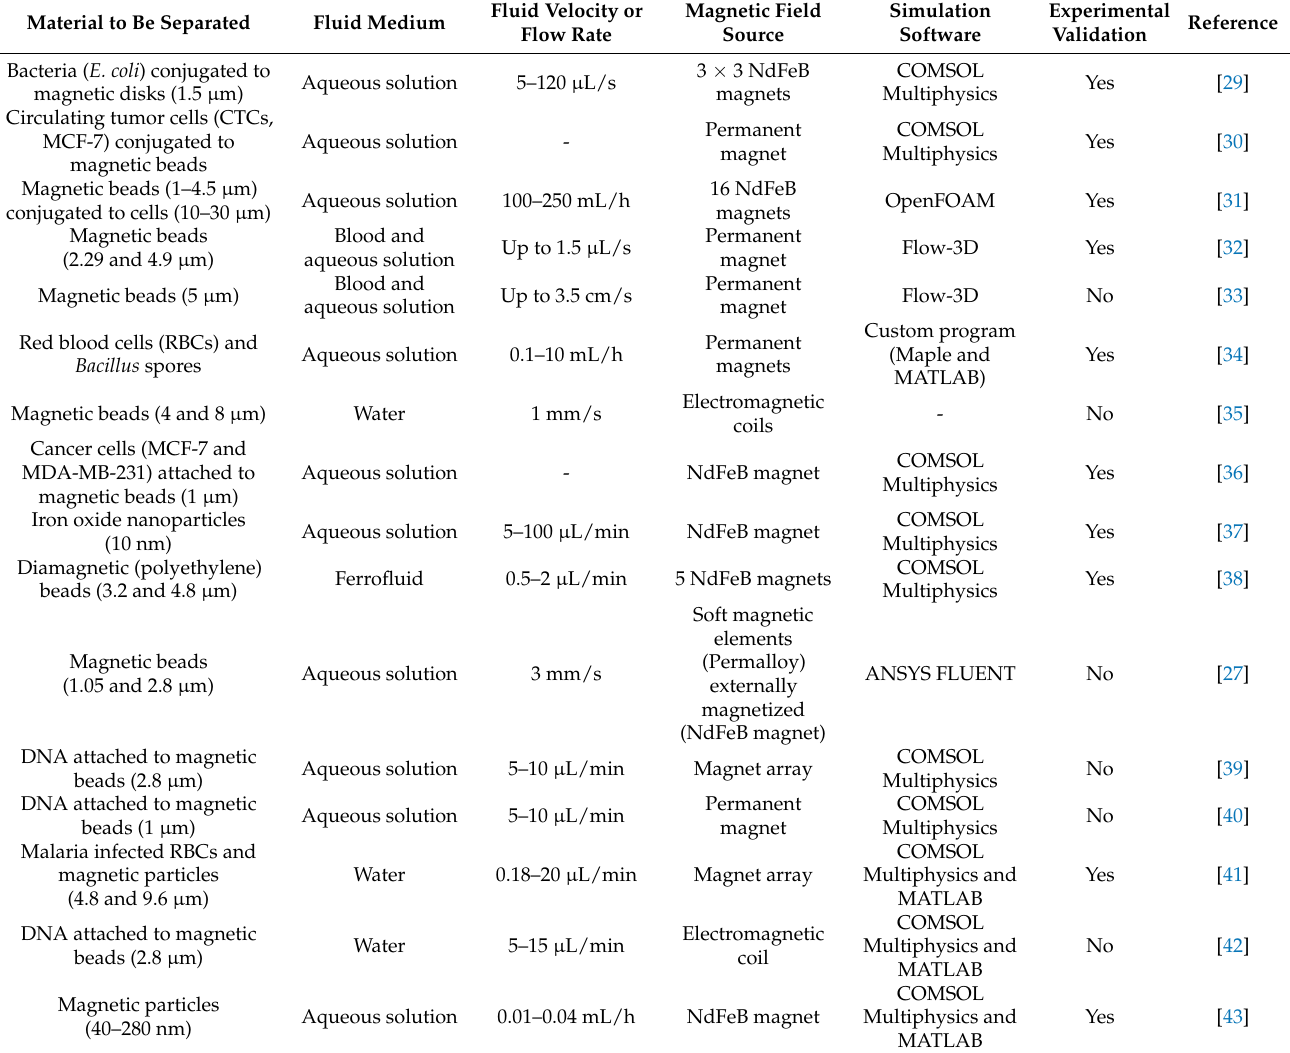
Table 1. Simulation studies dealing with particle and cell magnetophoresis in